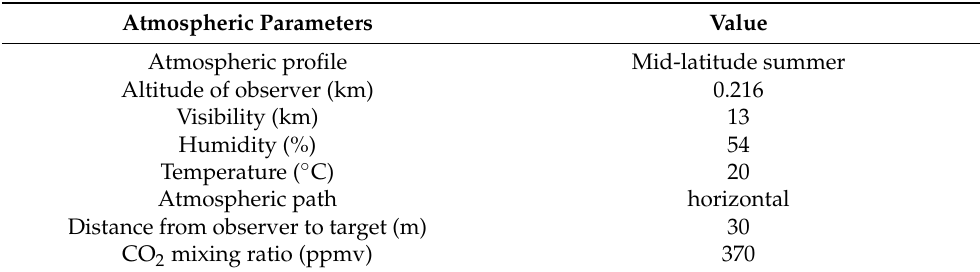
Table 5. Atmospheric parameters used in MODTRAN for the blackbody